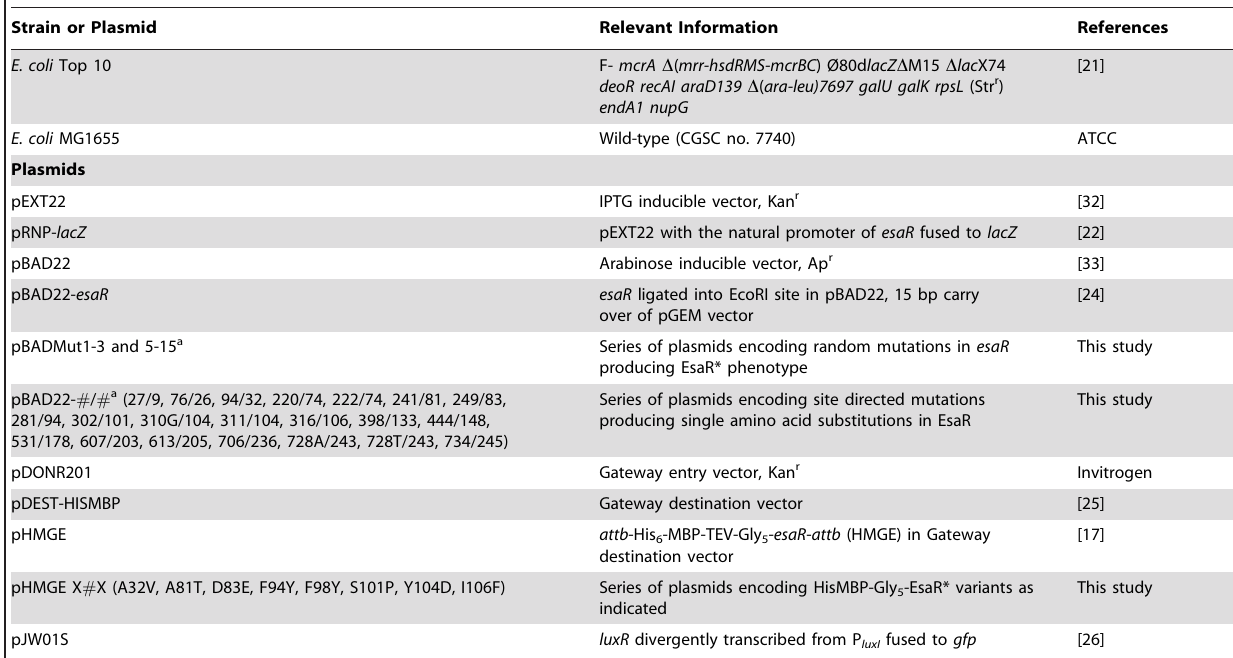
Table 1. Strains and plasmids used in this